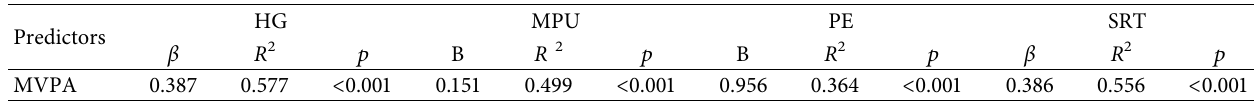
Table 4: Linear regression model relationship between physical fitness and MVPA (boys n � 1493).